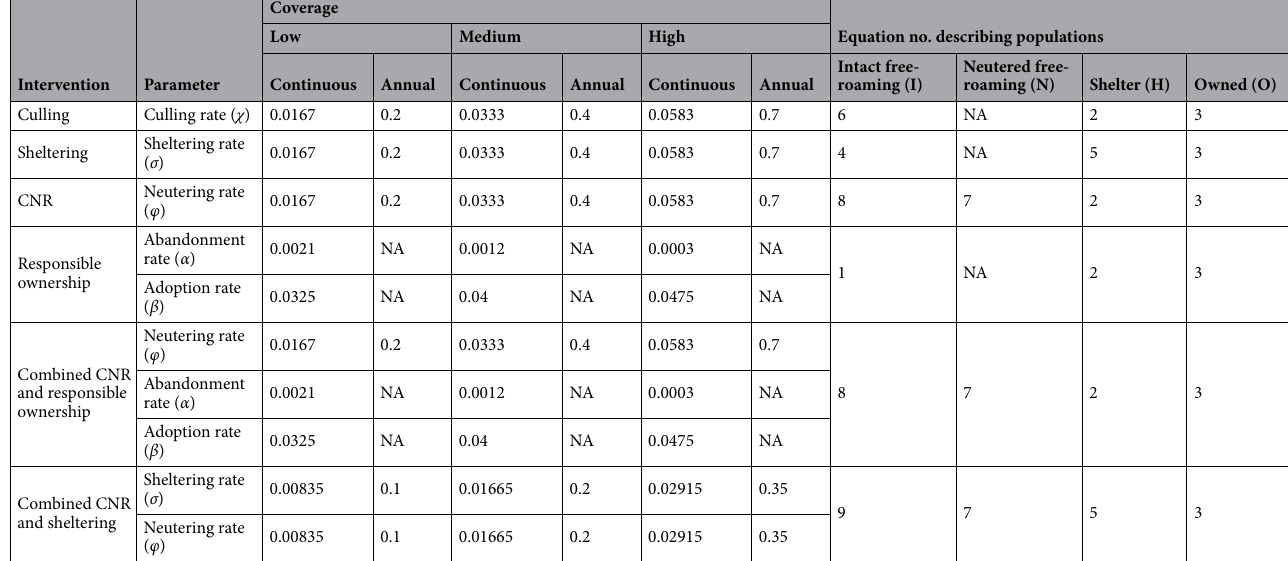
Table 2. Description of intervention parameters and coverages for simulations applied at continuous and annual